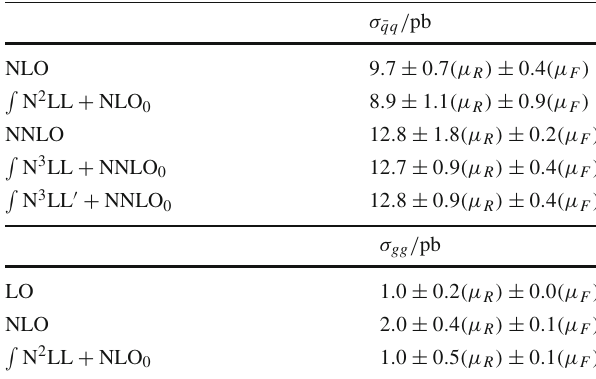
Table 1 Cross-sections at 8 TeV for q ¯ q and gg hard-function initiated processes with μ R = m γγ and smooth-cone isolation